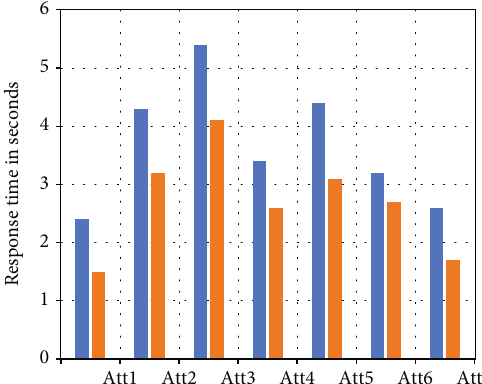
Figure 3: Response time comparison under multiple attributes.